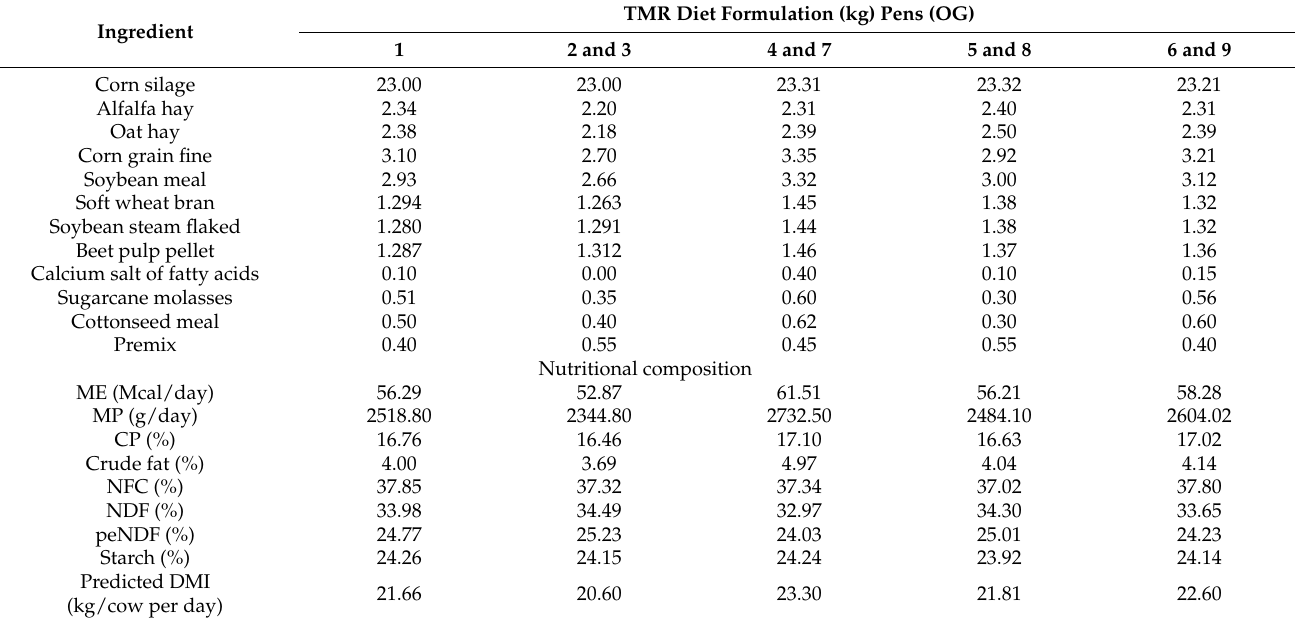
Table 1. Diet composition and routine nutrient composition—original farm grouping.